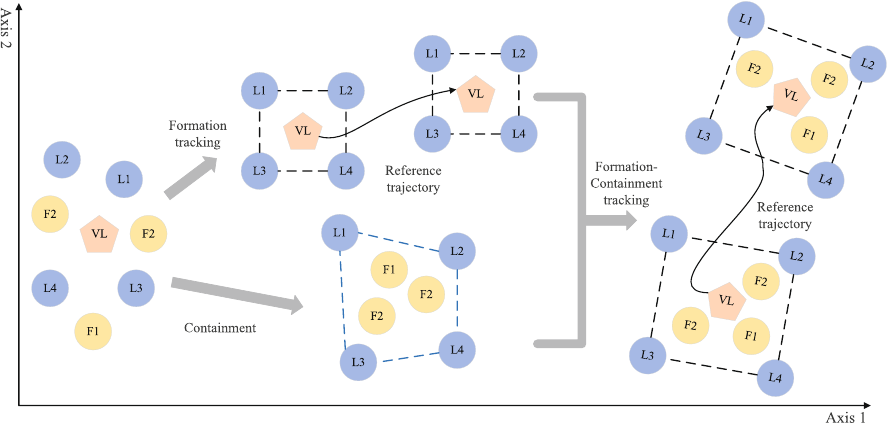
Figure 2. Formation-containment